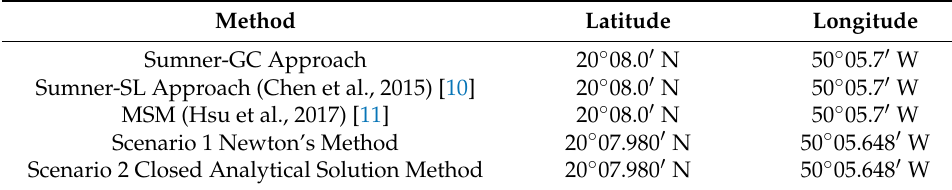
Table 5. The results of Example 2 of sun-run-sun observation fix.